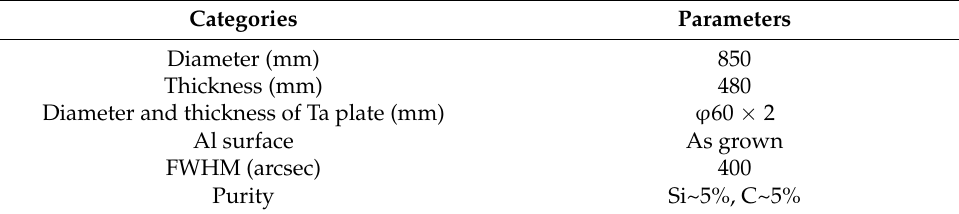
Table 2. The specifications of AlN crystal seed.